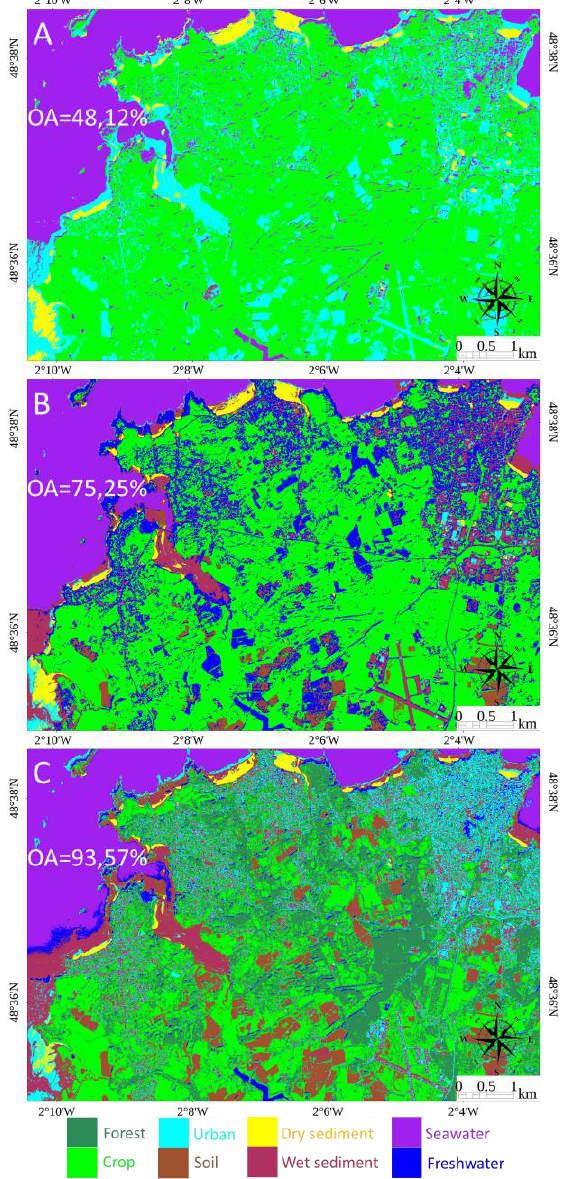
Figure 6 . Neural Network classification maps and overall accuracies of the 3-m (A) PS-2, (B) straightforward downscaled S-2, (C) stepwise downscaled S-2 datasets.